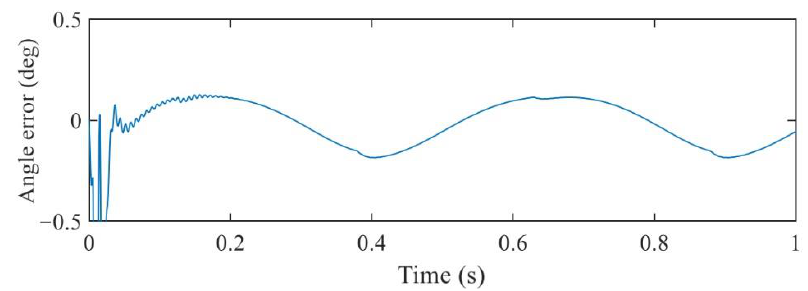
Figure 16. Backstepping HIL simulation error curve (second set of control parameters).